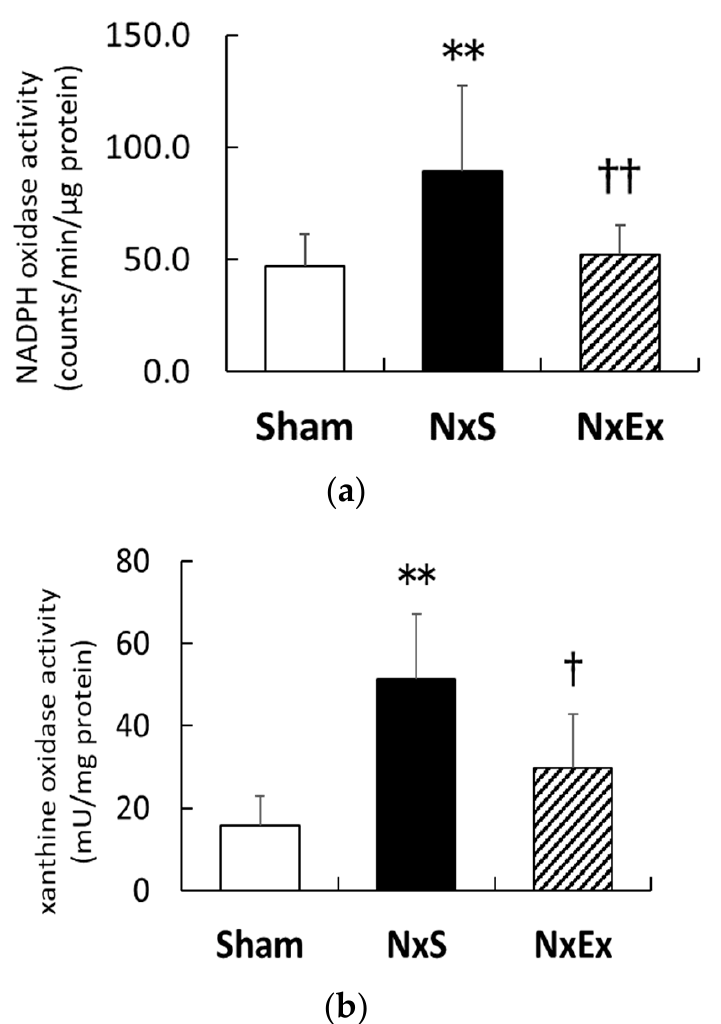
Figure 2. Effects of exercise training on the source of reactive oxygen species. The renal activities of nicotinamide adenine dinucleotide phosphate (NADPH) oxidase ( a ) and xanthine oxidase (XO) ( b ) were compared among the sham operation (Sham), nephrectomy sedentary (NxS), and nephrec- tomy exercise (NxEx) groups. Values are the means ± SEM. ** p < 0.01 compared with the Sham group, † p < 0.05, †† p < 0.01 compared with the NxS group. 3.4. Protein Expression of NADPH Oxidase Isoforms and XO Compared with the Sham group, Nx significantly increased the Nox2, Nox4, and XO expressions by 4.2-, 4.0-, and 7.8-fold, respectively, and exercise training significantly the Nx- increased Nox2, Nox4, and XO expressions 2.5-, 2.0-, and 1.8-fold, respectively. (Figure